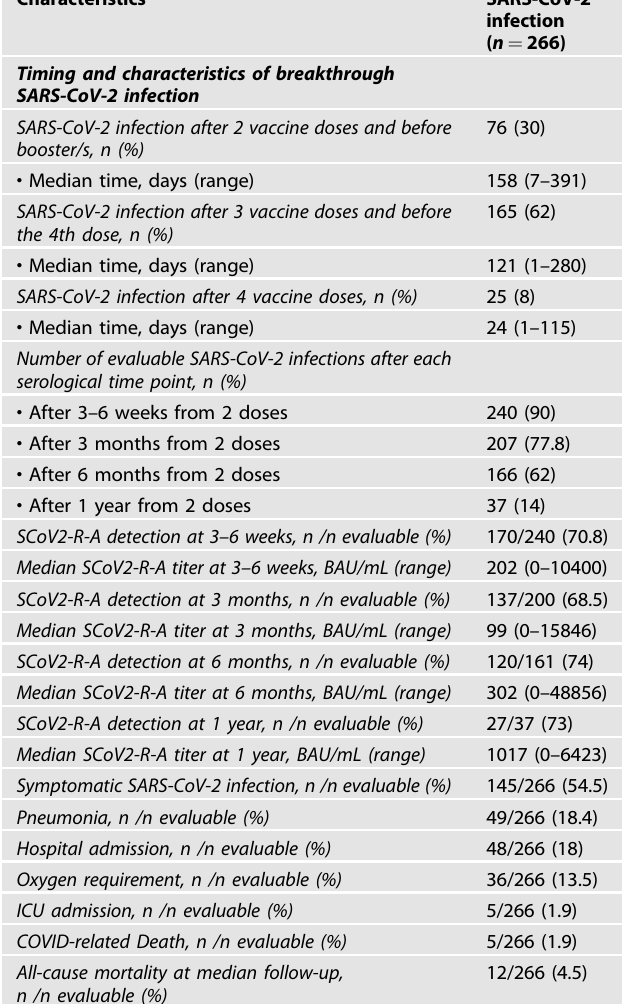
Table 2. Characteristics of patients with breakthrough SARS-CoV-2